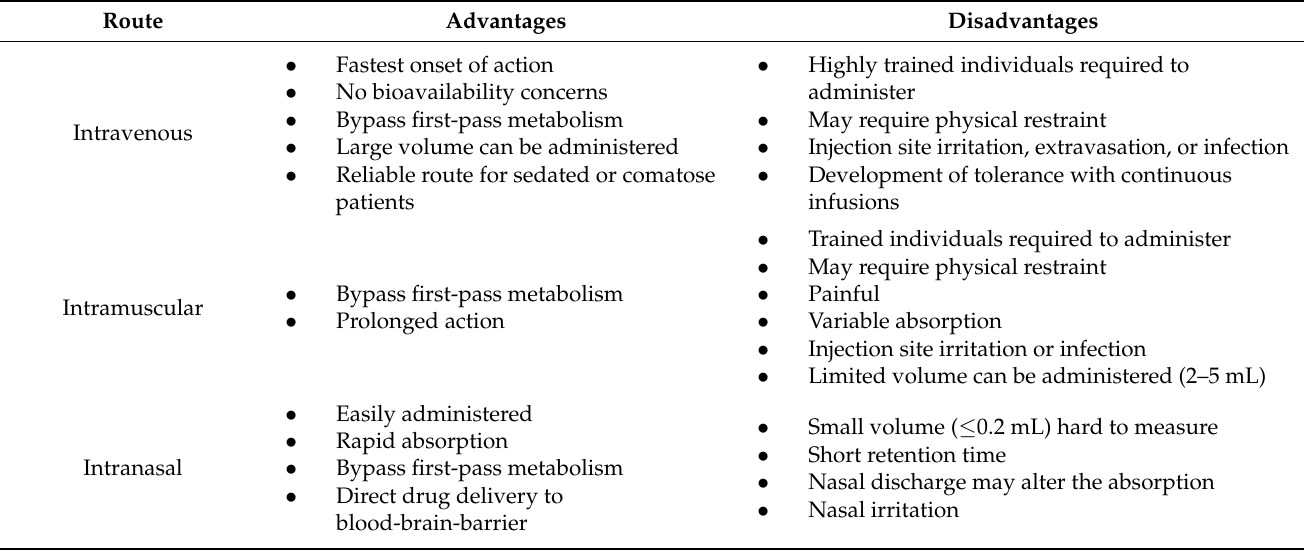
Table 4. Administration route advantages and disadvantages